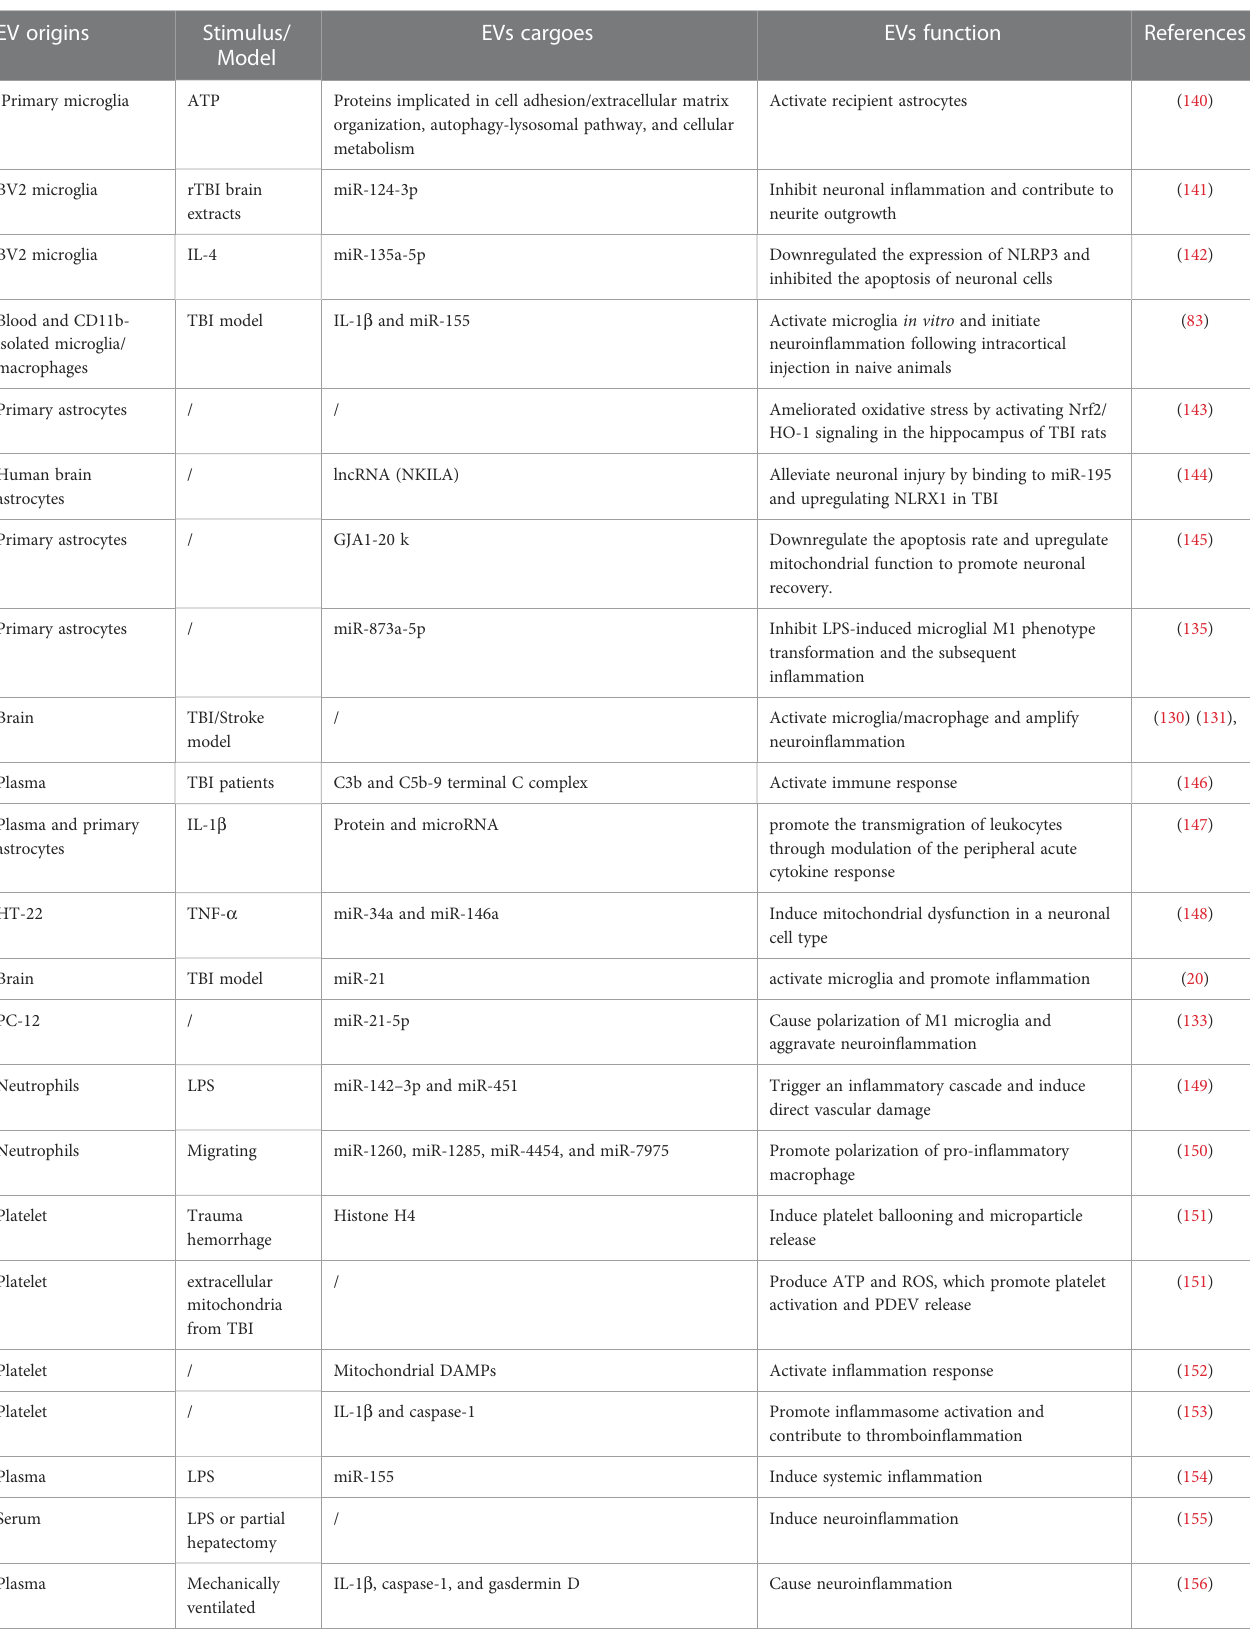
TABLE 1 Role of diverse EVs and their cargoes in TBI and in fl ammation